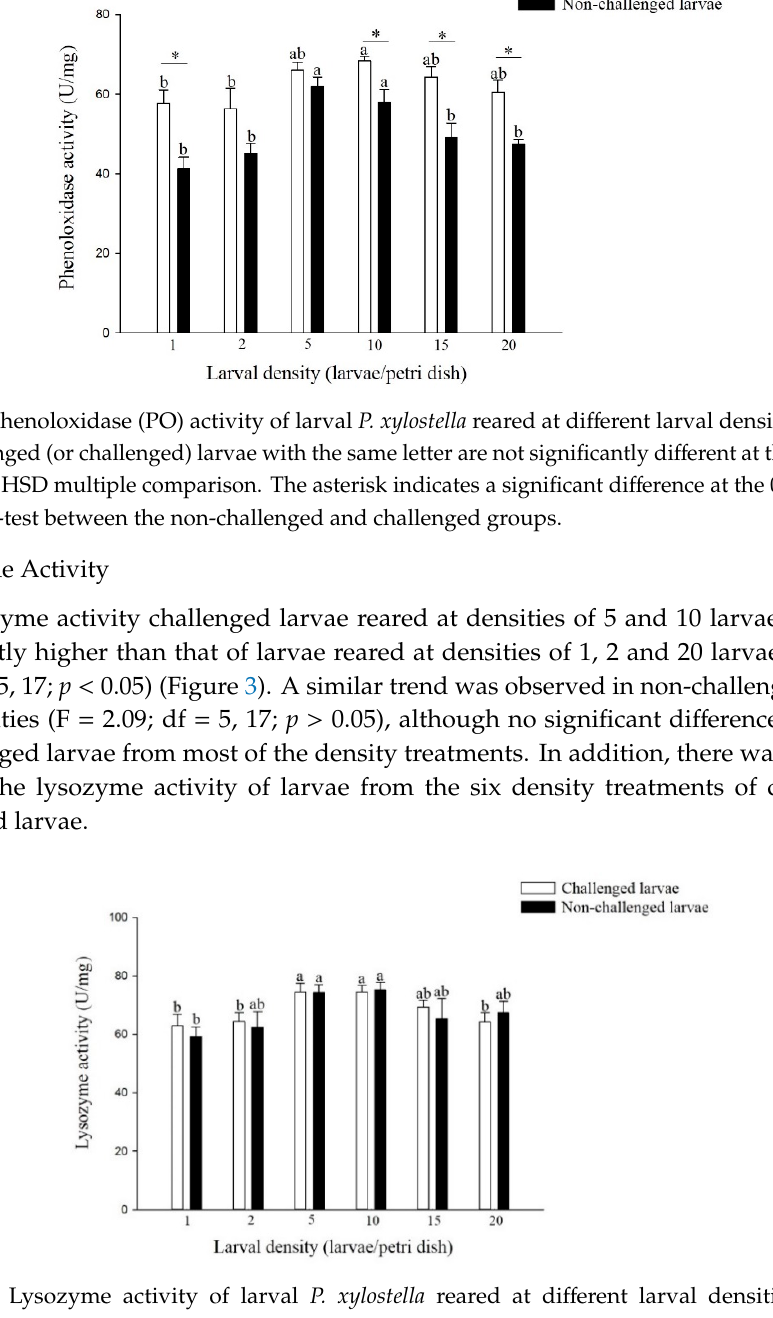
5 of 11 Figure 1. Survival analysis of larvae infected with granulosis virus at different larval densities. The average survival rates of larvae infected for 7 d at densities of 1, 2, 5, 10, 15, and 20 larvae per Petri dish were 63.33%, 66.67%, 70.00%, 66.67%, 73.33% and 76.67%, respectively. A log-rank test was used to determine which curves were significantly different from each other. Survival analysis was performed using the Kaplan–Meier estimator in SPSS 19.0. 3.2. Enzyme Activity 3.2.1. Phenoloxidase (PO) Activity The hemolymph PO activity differed significantly among different densities of non-challenged and challenged larvae (Figure 2). The PO activity of non-challenged larvae reared at 5 and 10 larvae per Petri dish was significantly higher than that of larvae reared at the other density treatments (F = 8.27; df = 5, 17; p < 0.05). A similar trend was observed in larvae challenged with different densities (F = 2.36; df = 5, 17; p > 0.05), and the challenged larvae from the density of 10 larvae per Petri dish